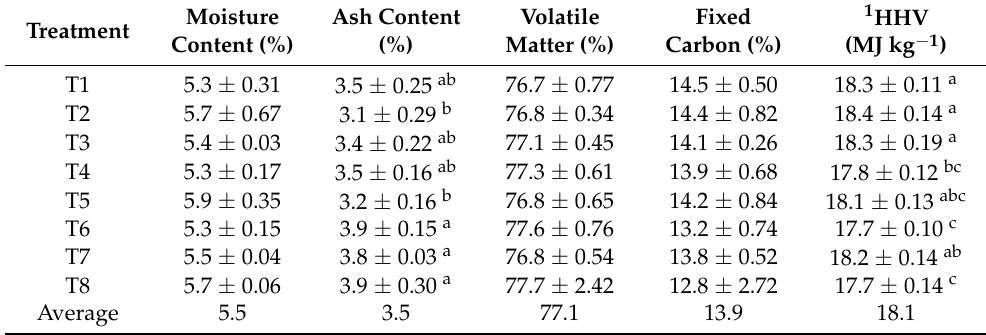
Table 5. Physicochemical properties of briquettes of several moisture pressure